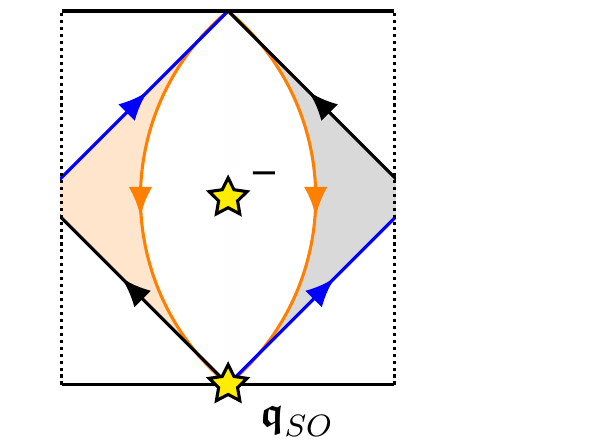
Figure 22. Sending the gauge coupling of the SO( N +1) factor to 0. Note that we shifted figure 21 horizontally by half a period before cutting open the torus into a cylinder, in order to focus on the strongly coupled